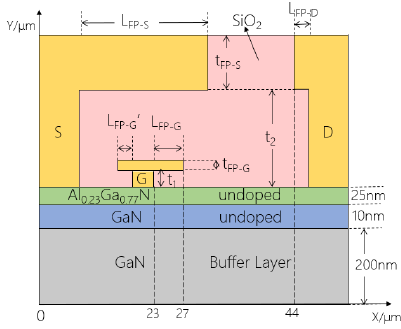
Figure 8. Device structure contained with FP-G, FP-S, and FP-D.